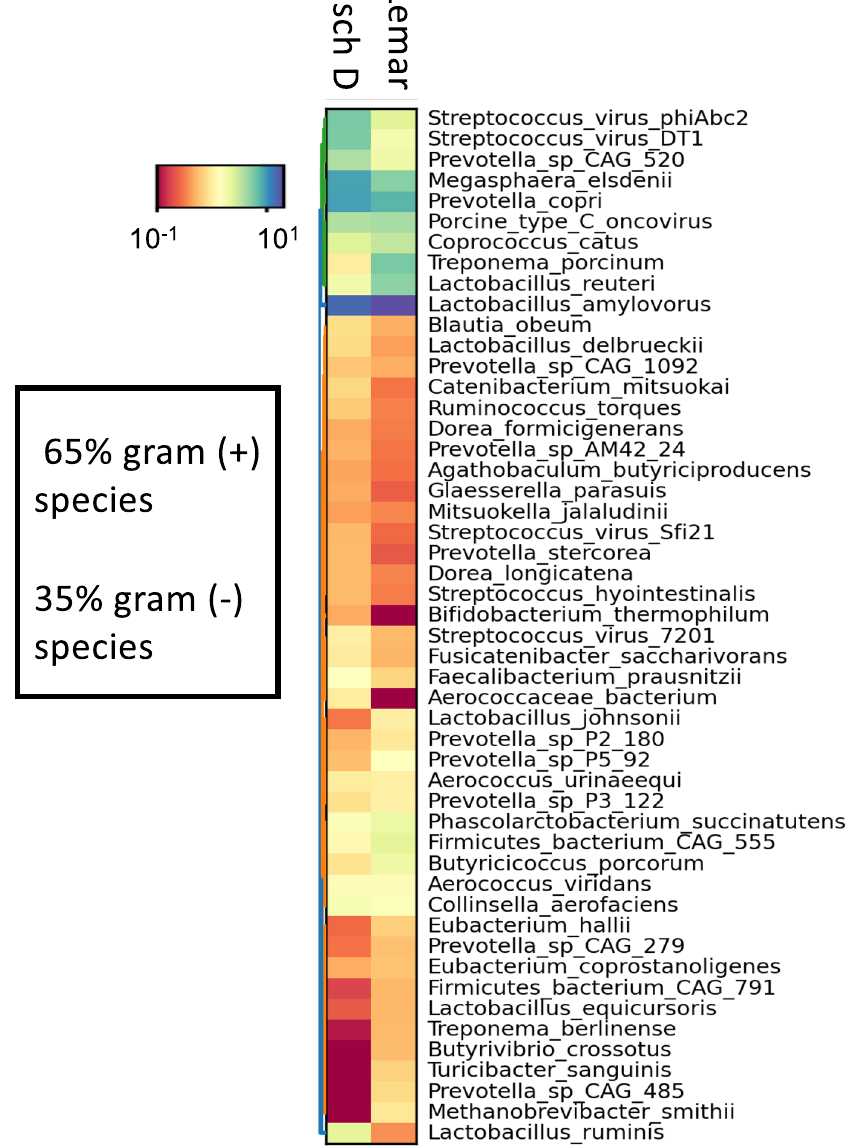
Figure 2. Dust-derived EVs contain DNA from both Gram (+) and Gram (−) bacterial species, as well as viral (bacteriophage) signatures. The 50 most prevalent signatures originated predominantly from Gram (+) bacteria (65%) commonly found in feces, soil, and as part of the normal swine gut flora. Several pathologic species were also